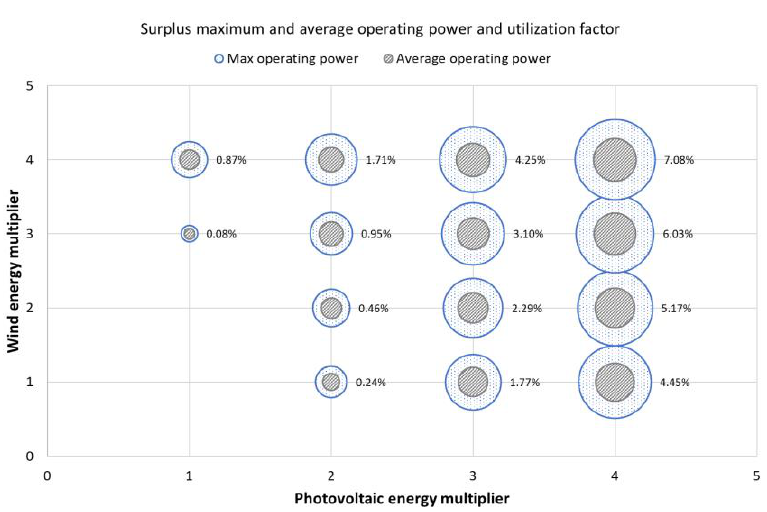
Figure 19. Maximum and average operating power for energy surplus user, and utilization factors for different values of wind and photovoltaic productions.